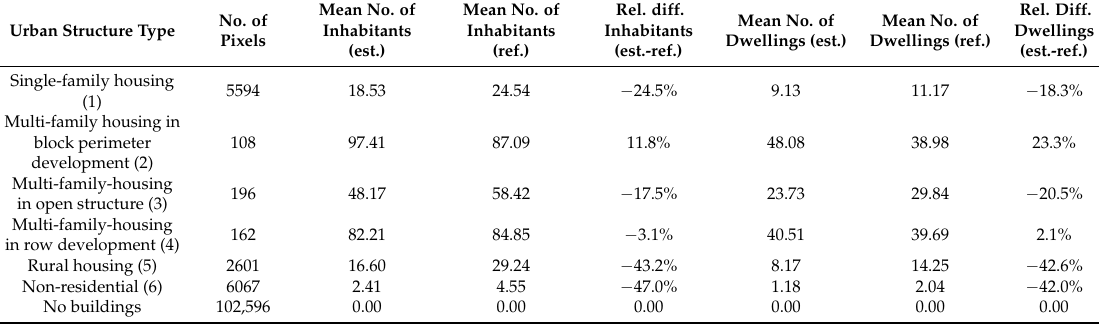
Table 3. Absolute error (dwelling units) of the results for different structural building types.